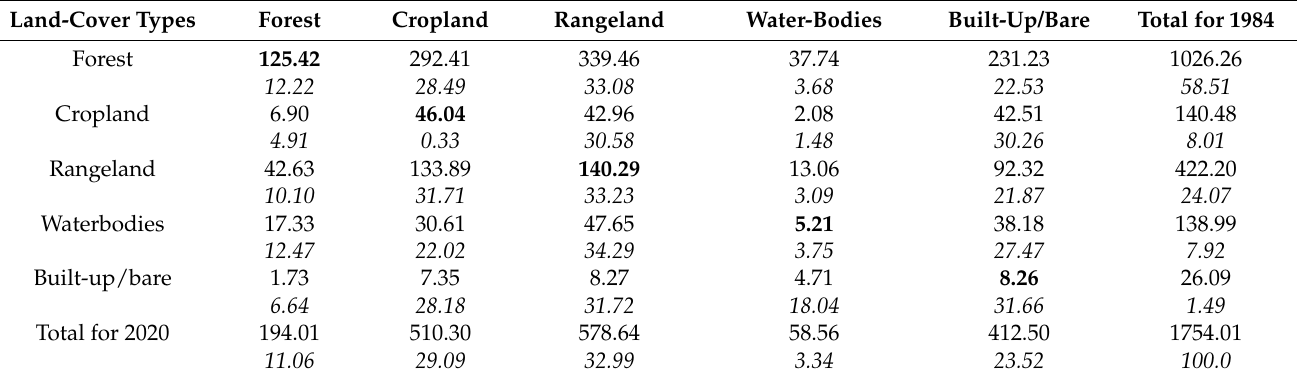
Table 4. Landscape transition in km 2 and percentage (%) of the total land-use cover.